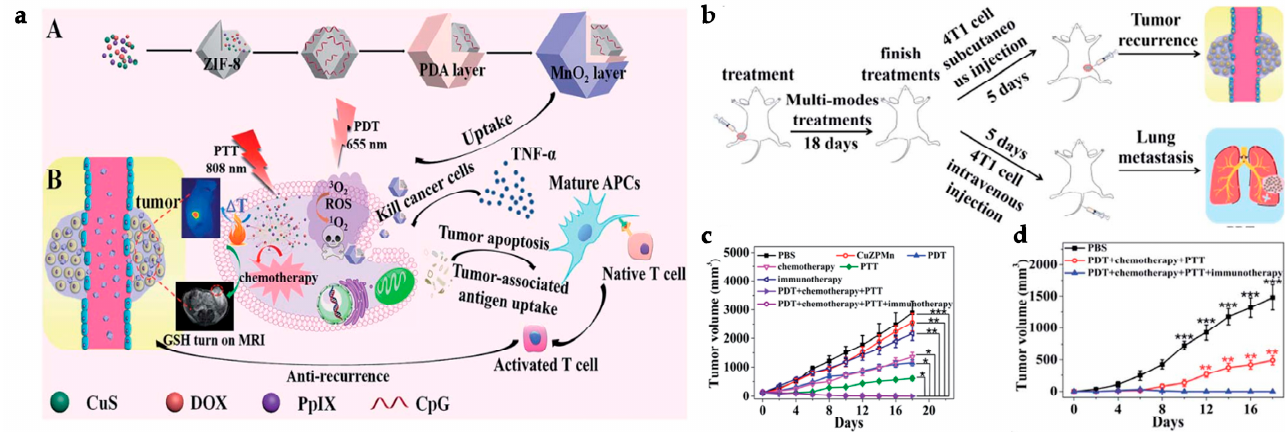
Figure 9. MOF-based synergetic “all-in-one” strategy. ( a ) CuZPMn@PpIX/DOX/CpG was synthe-